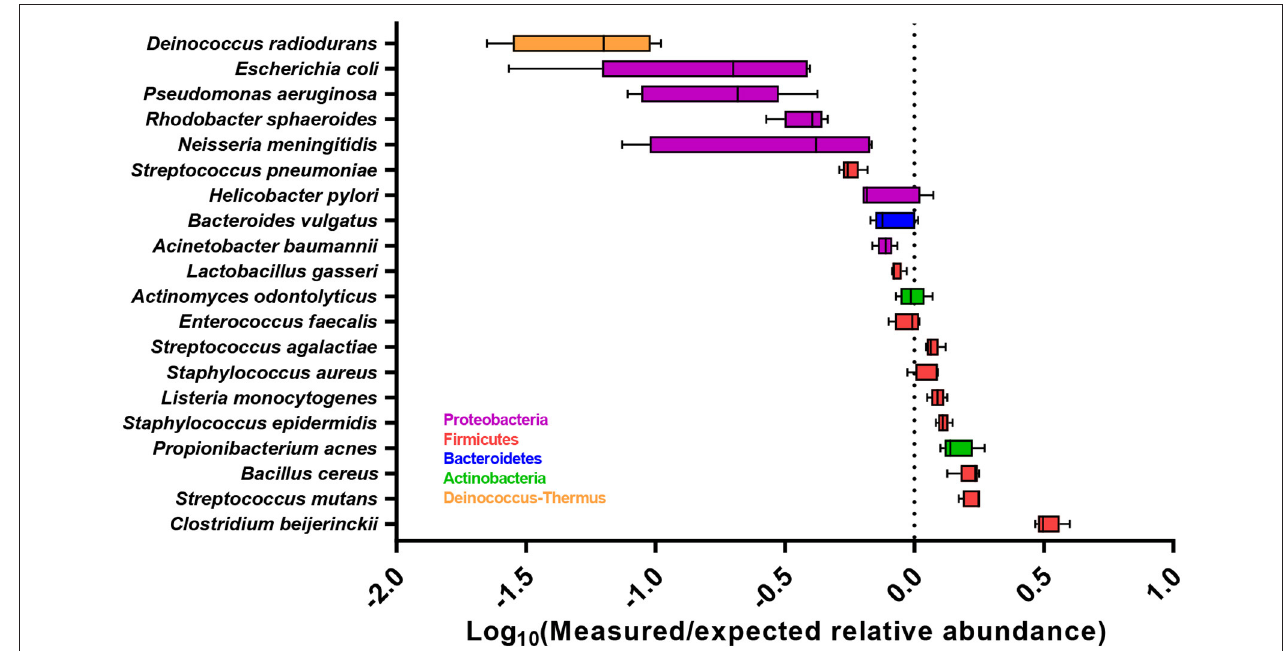
FIGURE 2 | Accuracy of the abundance estimates across all five sequencing runs for each bacterial species, expressed as the Log 10 ratio of measured relative abundance to the expected relative abundance. Boxplot show the median with 25 and 75 percentiles within the box and whiskers show the range. Dashed line indicates the expected relative abundance of